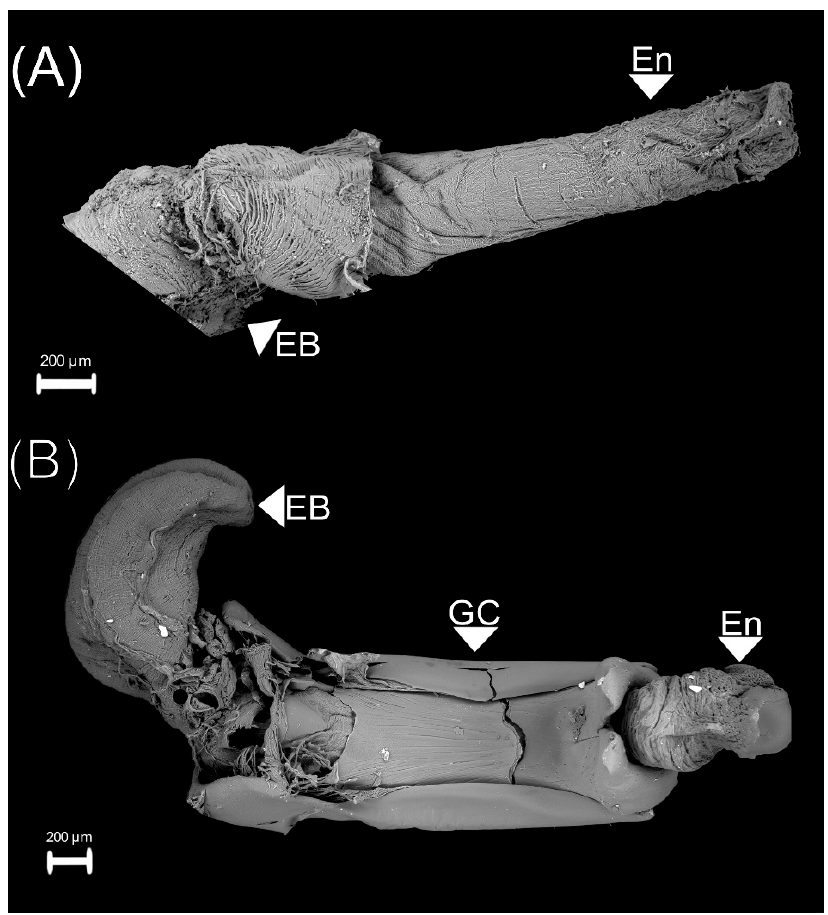
Figure 2. Endophallus of 18 d old Cyclocephala barrerai male. ( A ) endophallus and ejaculatory bulb, ( B ) genital capsule and endophallus. En = endophallus, EB = ejaculatory bulb, GC = genital capsule.